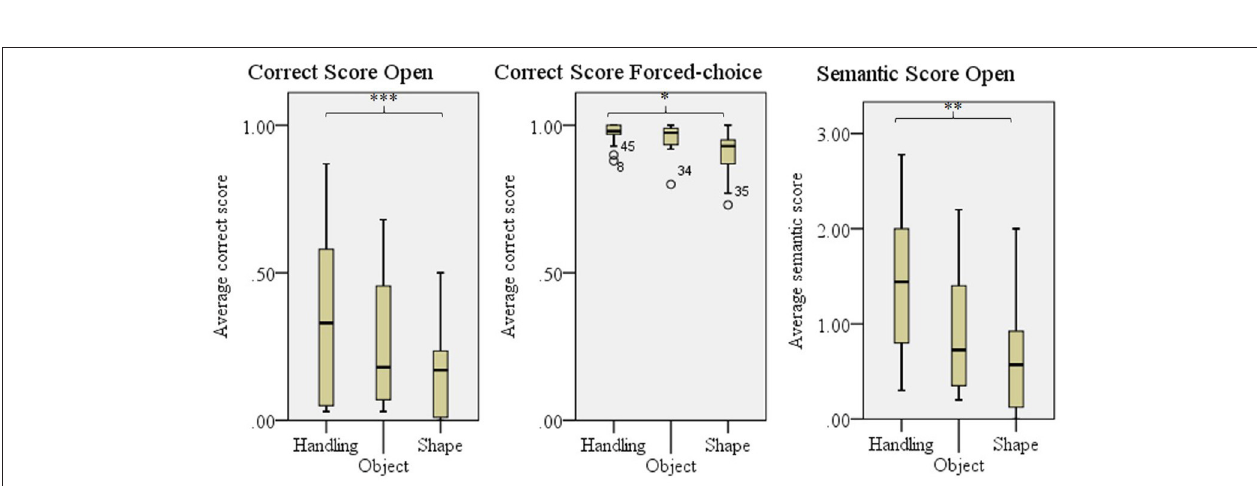
FIGURE 6 | Comprehensibility scores for objects per default technique; Handling, Object, and Shape (used by 80% or more of the participants). Enact was not used frequently enough to perform further analyses on. Error bars show SD. * p < 0.050, ** p < 0.010, *** p < 0.001.